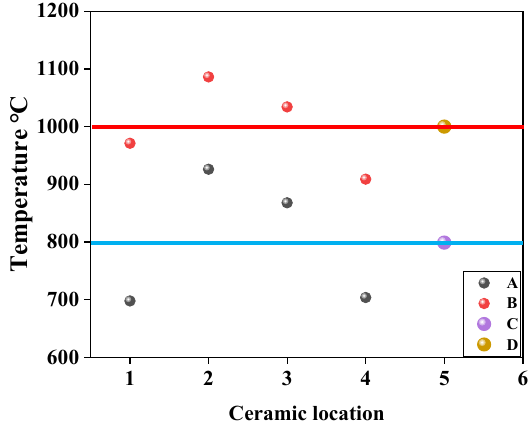
Figure 4. Empty chamber temperature.